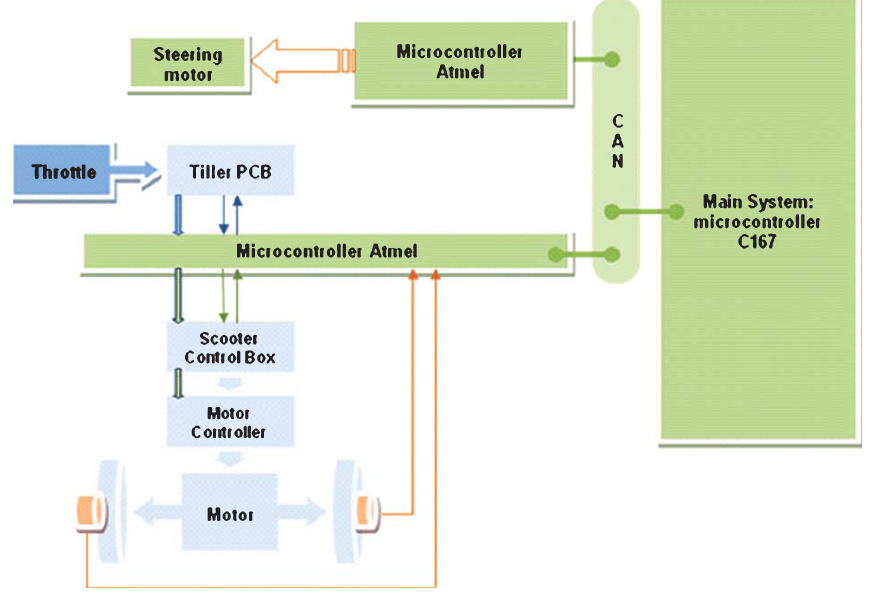
Fig. 3. The scooter electronics and the extensions (blue: the origin electronics, green: additional mounted